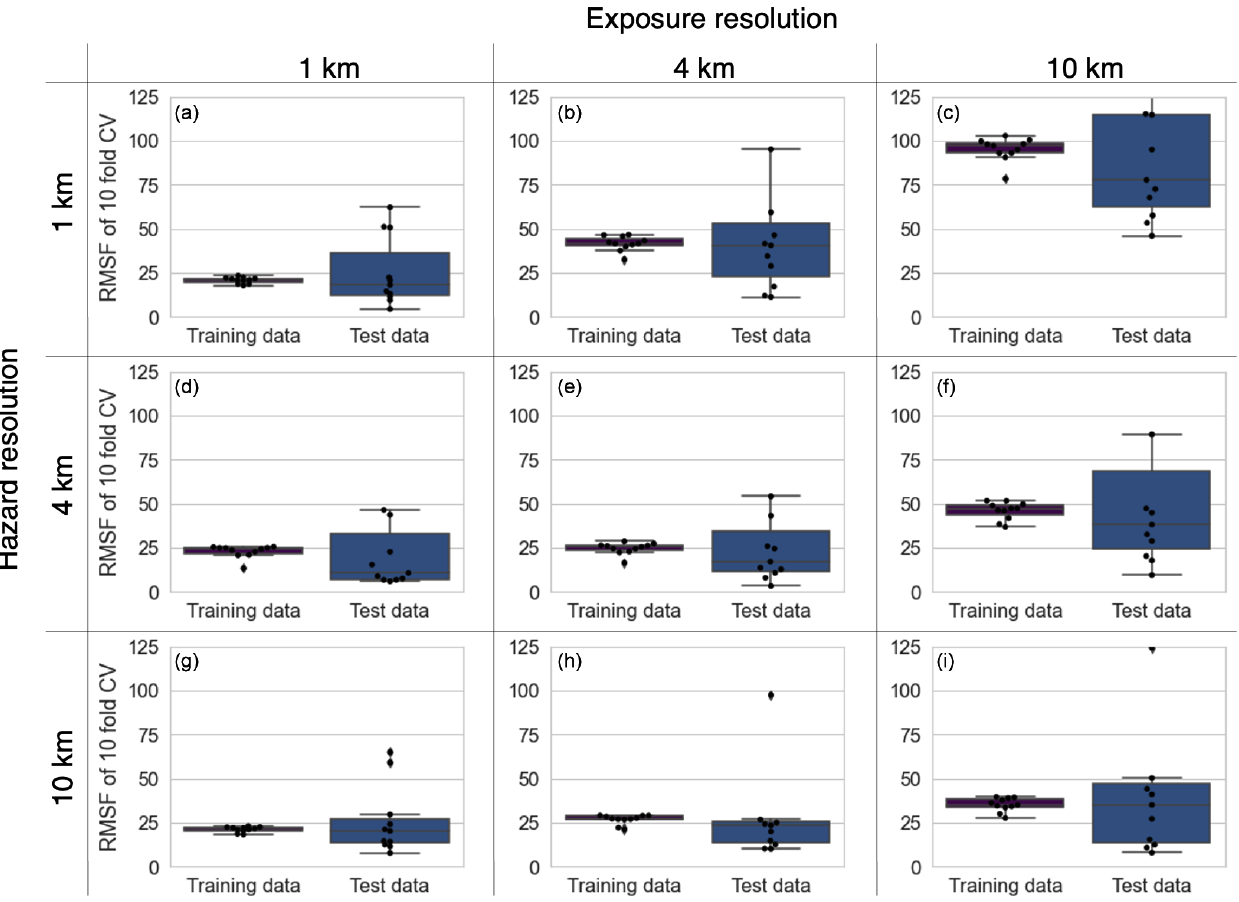
Figure A3. Boxplots of RMSF of training and testing error as a result of a 10-fold cross-validation (CV) for different hazard and exposure resolutions. The black dots indicate individual results of each calibration. RMSF become smaller with higher exposure resolution. Testing errors are well in line with training errors, indicating no heavy data